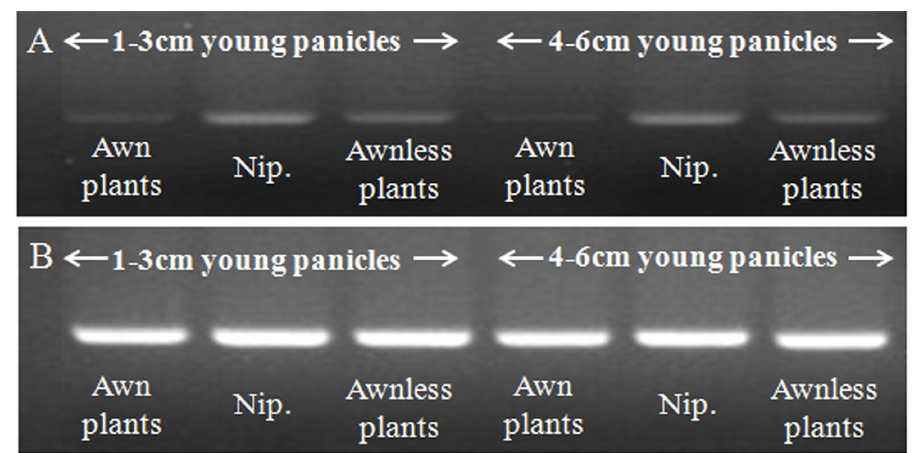
Fig 3. Semi-quantitative analysis of expression of candidate genes in awned and awnless plants, with Nipponbare as a control. (A) Expression of Os03g0418600 ; (B) Expression of actin1 under the same